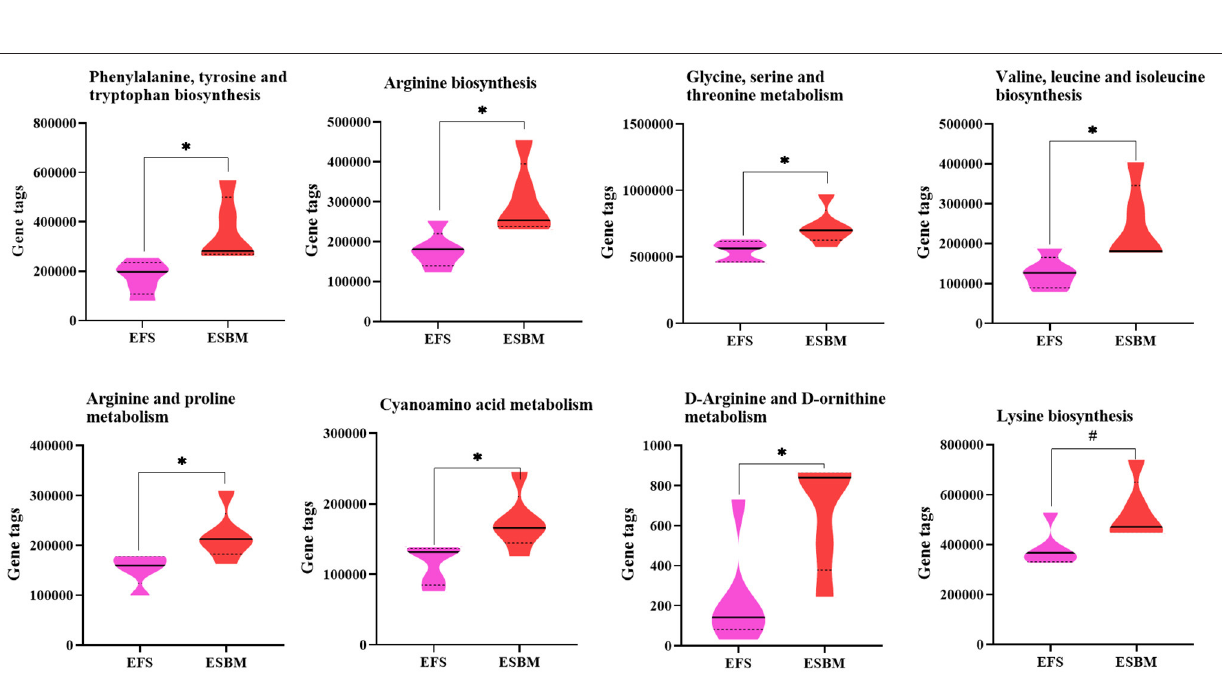
Frontiers in Veterinary Science |